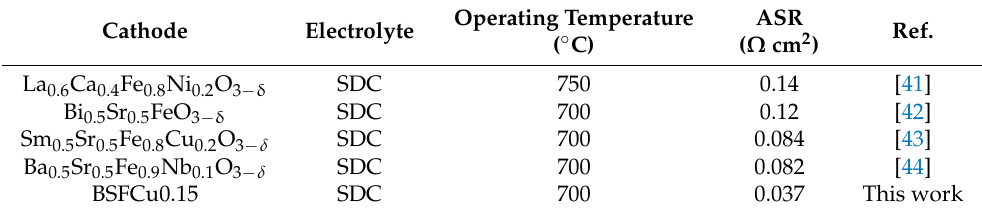
Table 4. ASRs for different iron-based electrodes. Cathode Electrolyte